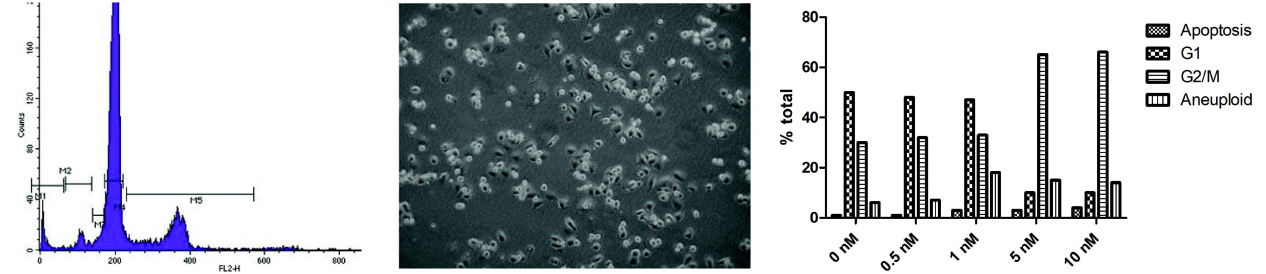
Figure 2. Cell cycle arrest. Concentration-dependent G2/M arrest caused by OXi6196 in MDA- MB-231 cells, as assessed by flow cytometry. G2/M blockade was observed at 5 nM with a significant increase in aneuploidy. Cells have started to round and detach. Effects on cell cycle progression and corresponding images are shown in Supplementary material Figures S1 and S2 for OXi6196 and OXi6197,